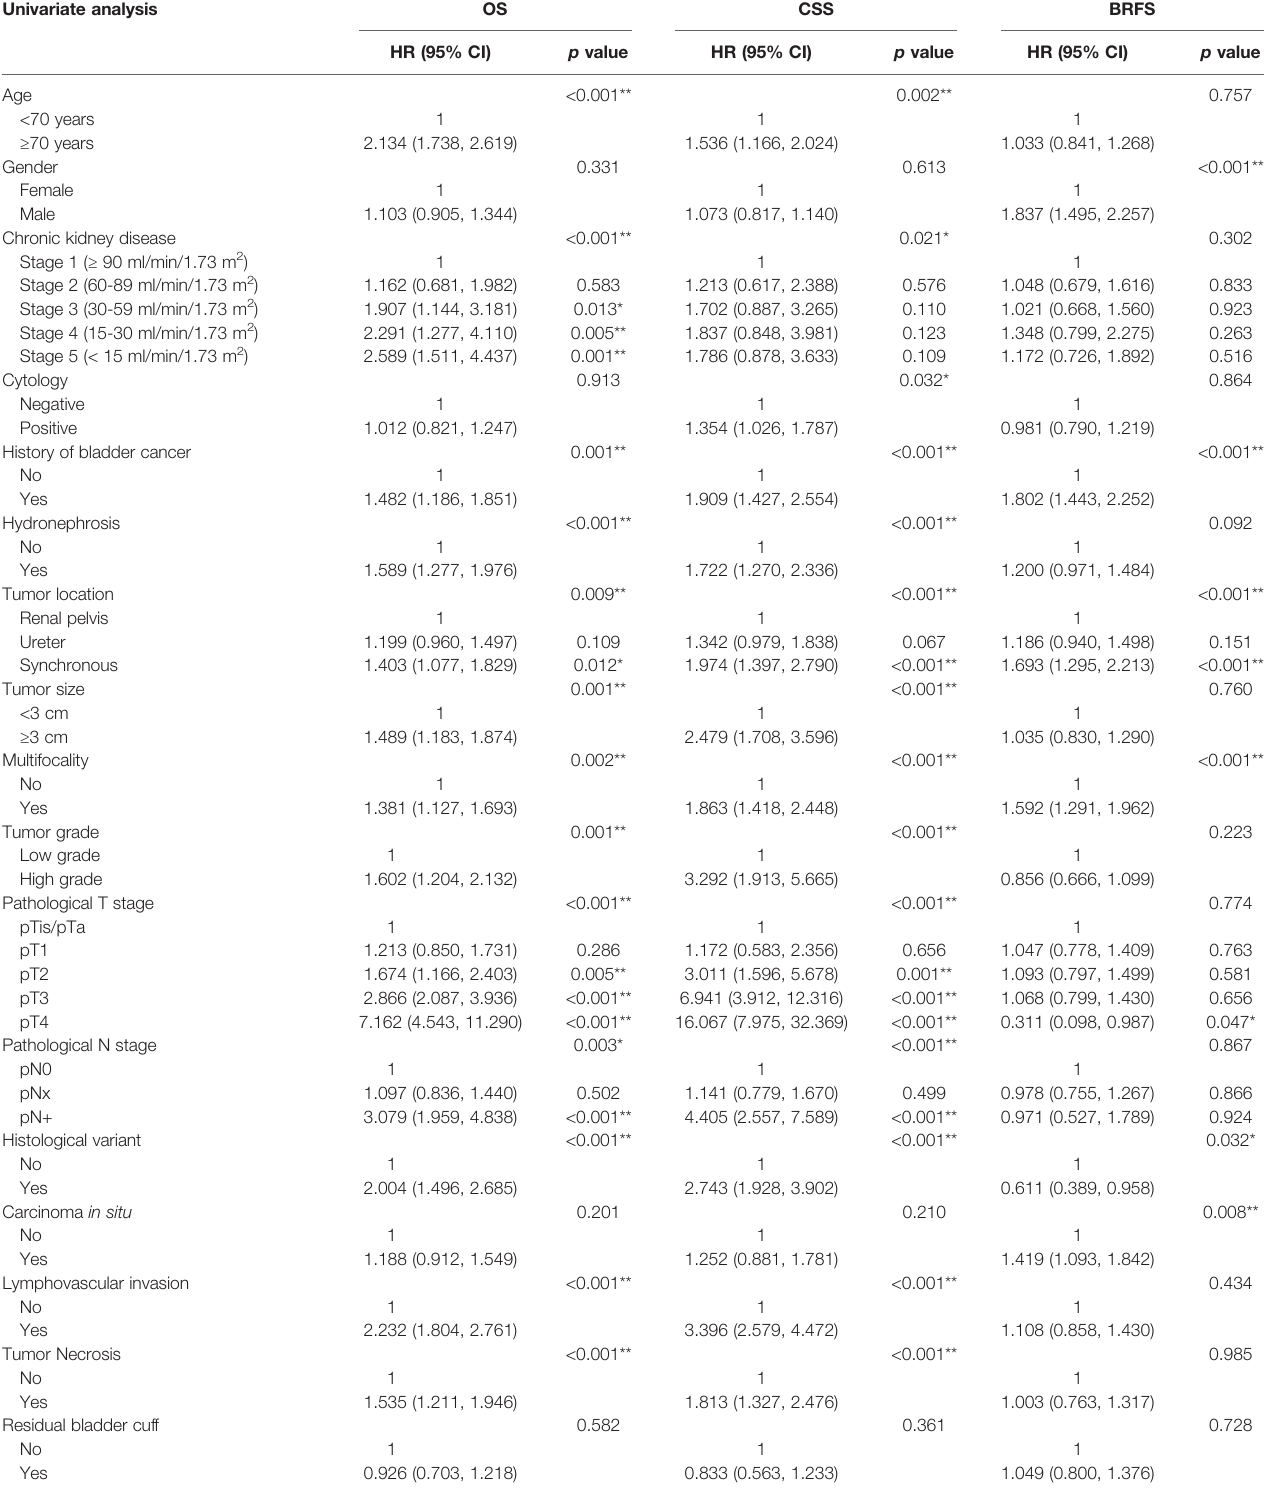
TABLE 2 | Comparative univariate survival analysis of UTUC patients receiving minimally invasive NU. Univariate